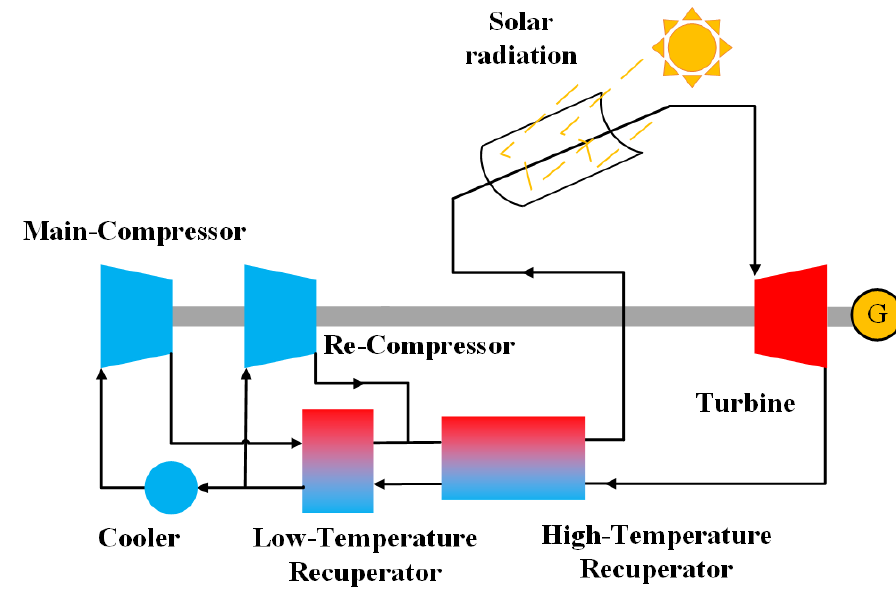
Figure 3. Configuration of the recompression cycle.